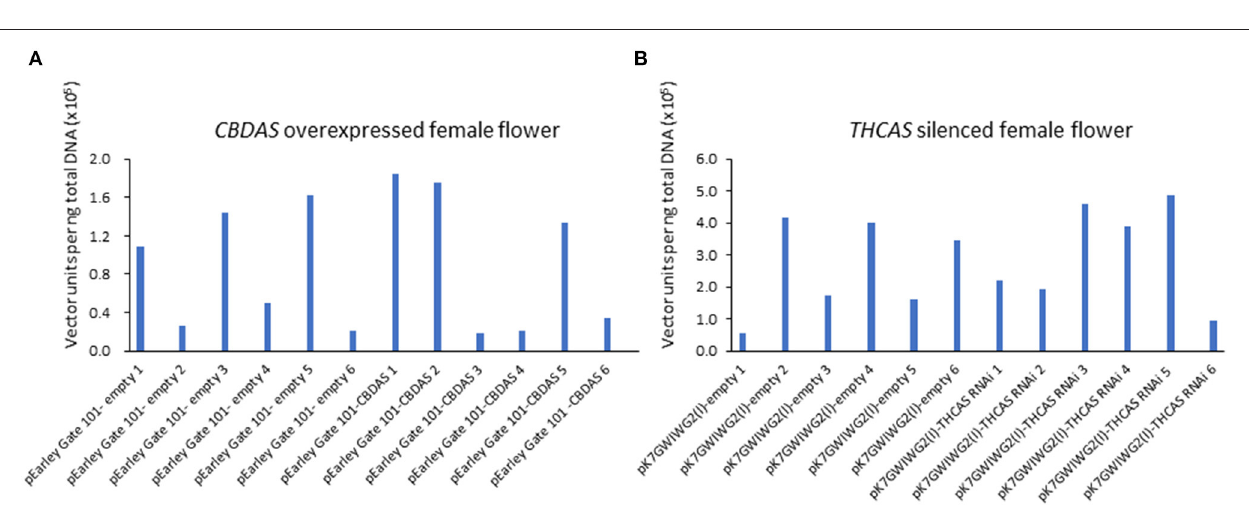
THCA, and CBCA, as suggested previously (Hurgobin et al.,